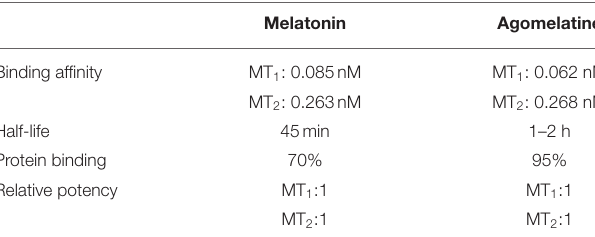
TABLE 1 | Some properties of melatonin and agomelatine